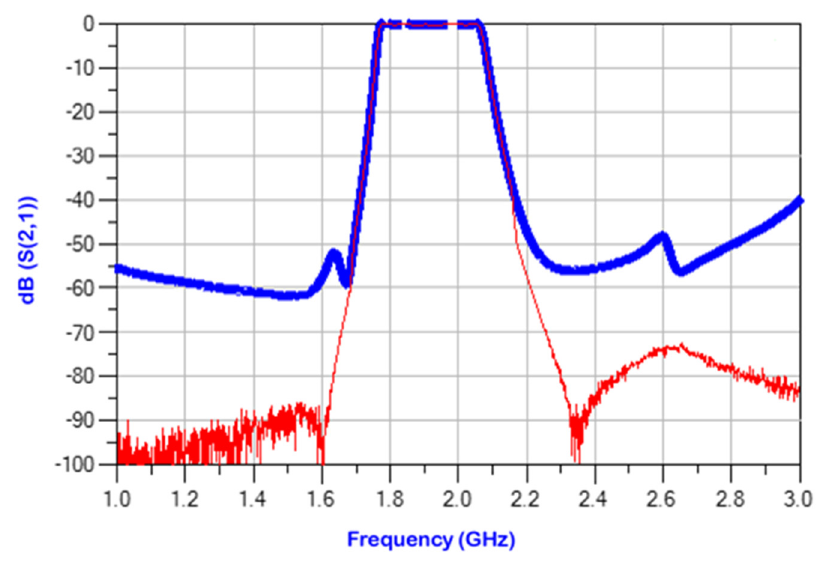
Figure 4. Measured S 21 for the preliminary package (thick blue) and improved packaging (thin red) vs. frequency.